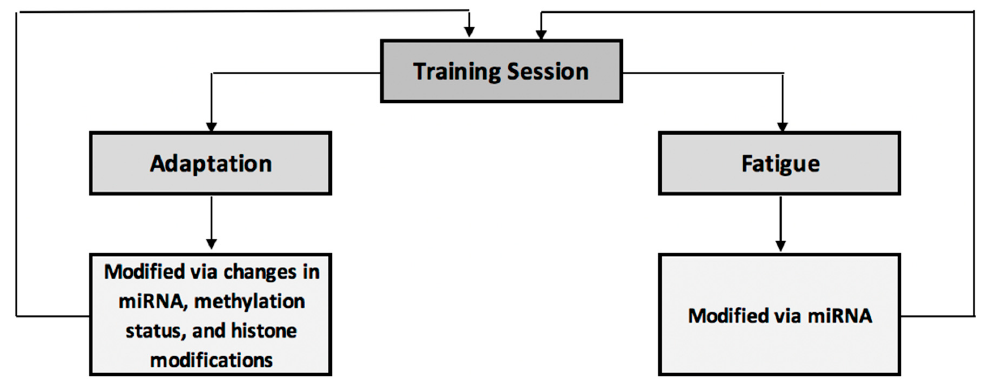
Figure 1. Summary of epigenetic influences on training-induced adaptation and fatigue. 4.2. Cell-Free DNA (cfDNA): A Novel Marker of Exercise Adaptation?